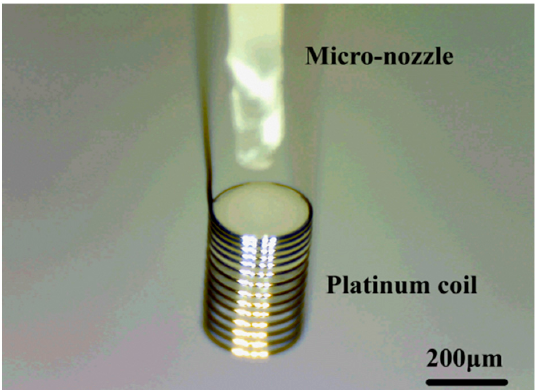
Figure 5. Manufacturing process of the catalytic gas sensor.